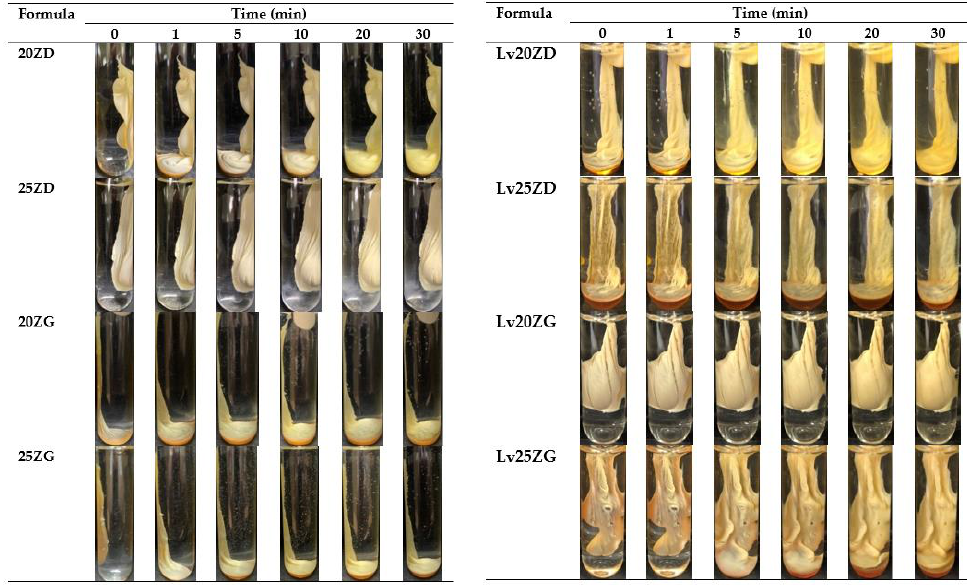
Figure 3. Gel formation of drug-free and Lv-loaded zein-based ISG formulations after injection into the phosphate buffer pH 6.8.